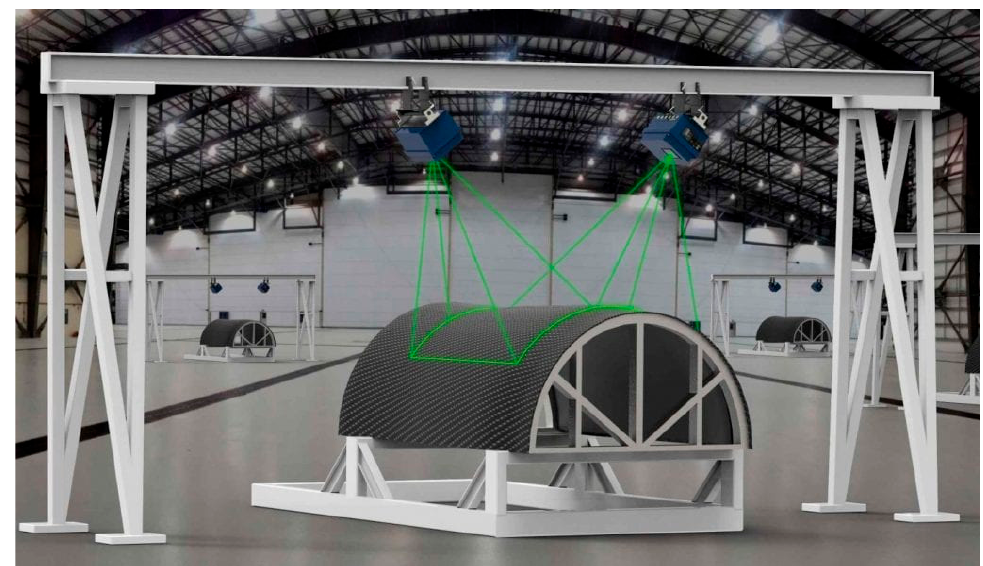
Figure 8. Principle of projection laser systems application [111].